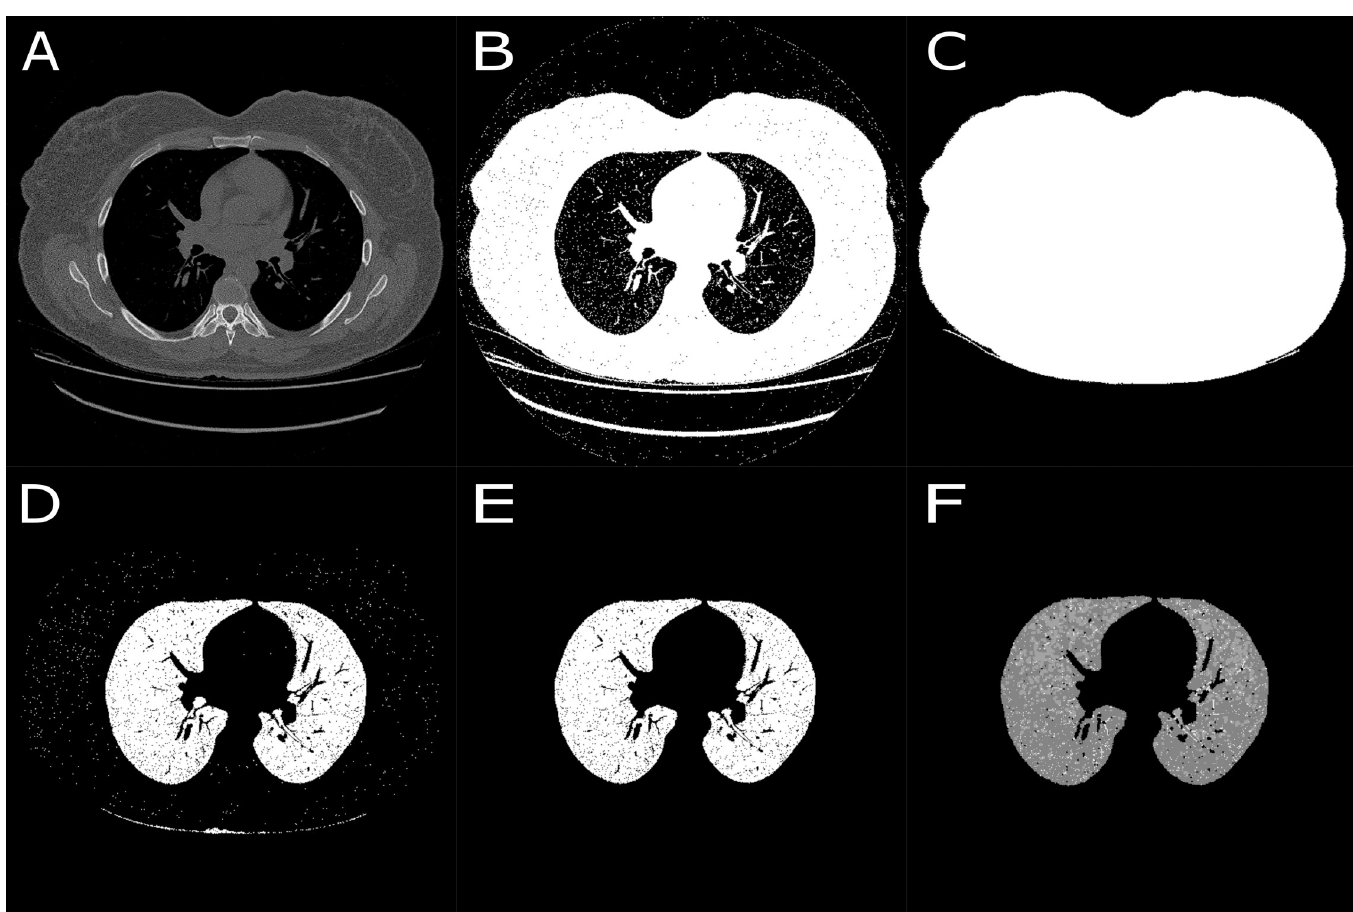
Fig 2. Sequence of images that demonstrate the algorithm steps. A–Original image; B–First thresholding; C–Body segmentation; D–Second Threshold; E–Lung Segmentation and F–Final segmentation.